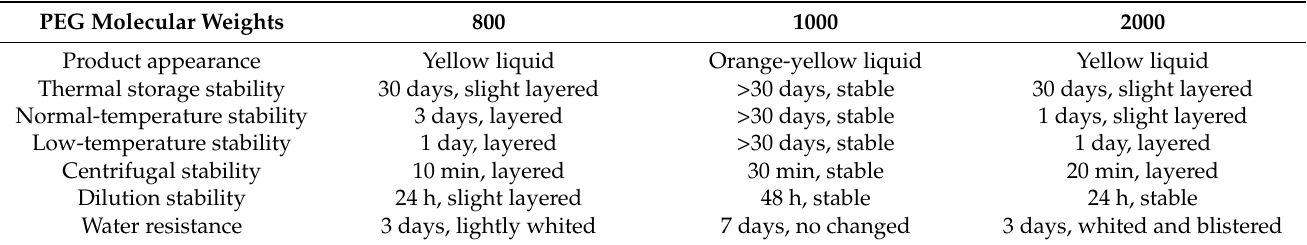
Table 2. Effect of PEG molecular weight on waterborne epoxy curing agent and film performance.